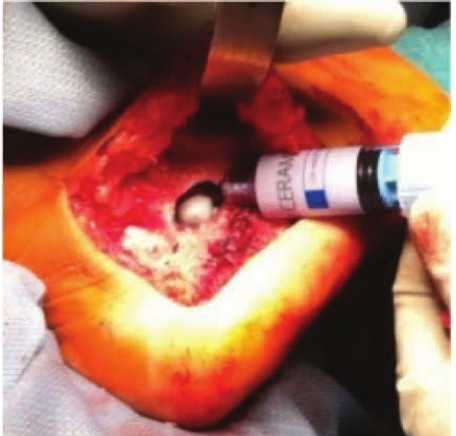
Figure 5: Intraoperative view of CERAMENT filling the void of the distal part of the femur together with the allogenic bone debris.